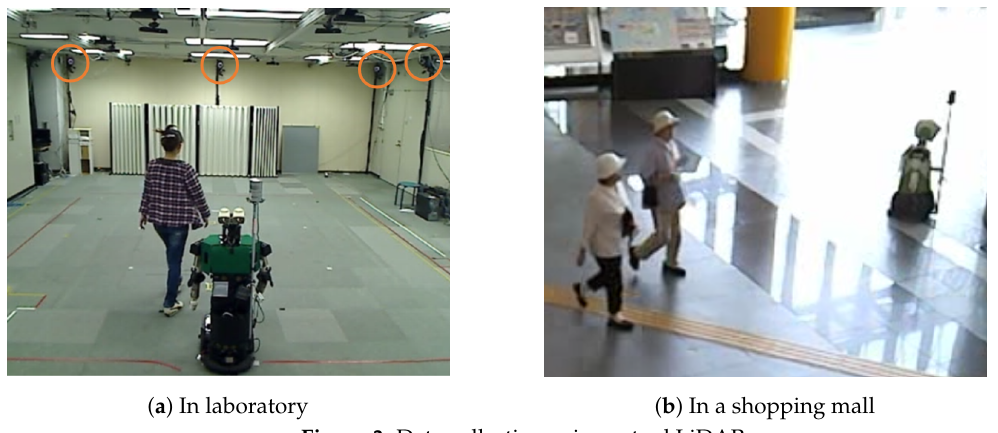
Figure 3. Data collection using actual LiDAR